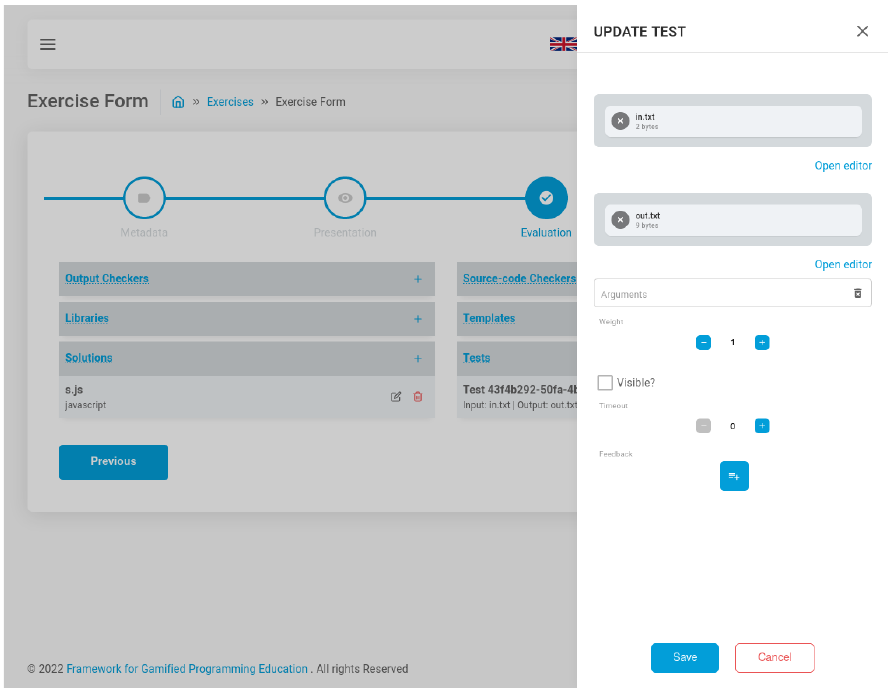
Figure 2. Screenshot of FGPE AuthorKit while editing a test on the exercise